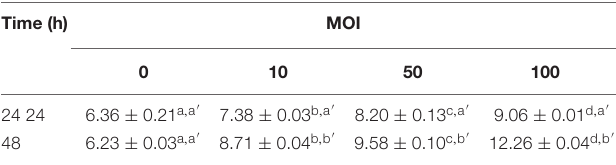
TABLE 2 | Mitochondrial membrane potential ratio (green fluorescent/red